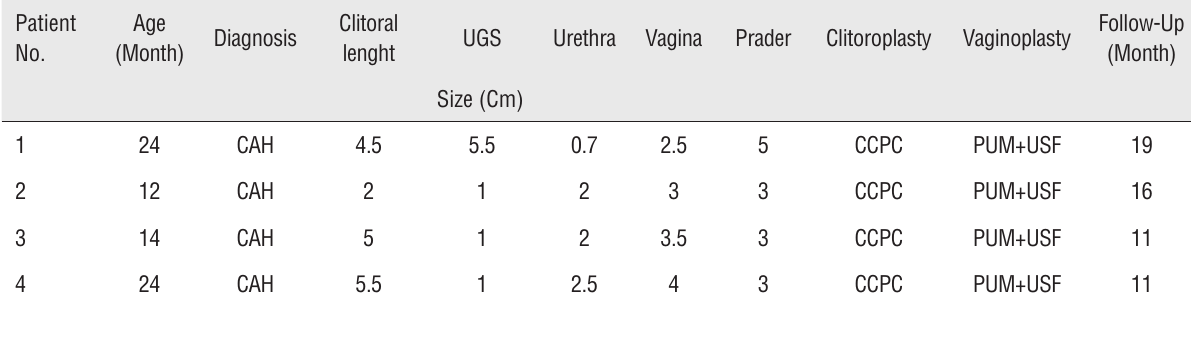
UGS: Urogenital sinus, CAH : Congenital adrenal hiperplasia, CCPC: Complete corporeal preservation clitoroplasty, PUM: Partial urogenital mobilization, USF: Urogenital Sinus